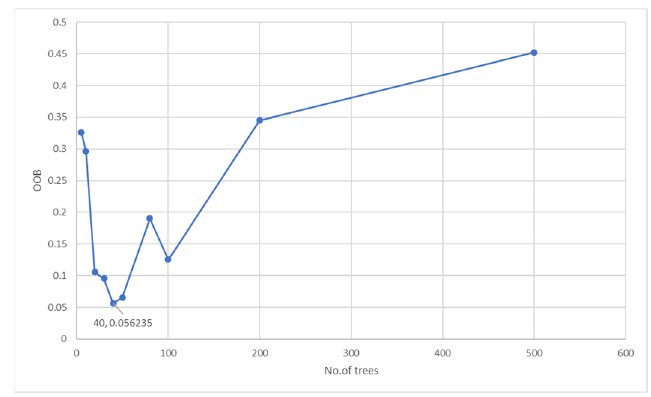
Figure 4. Effect of the number of trees on OOB error.